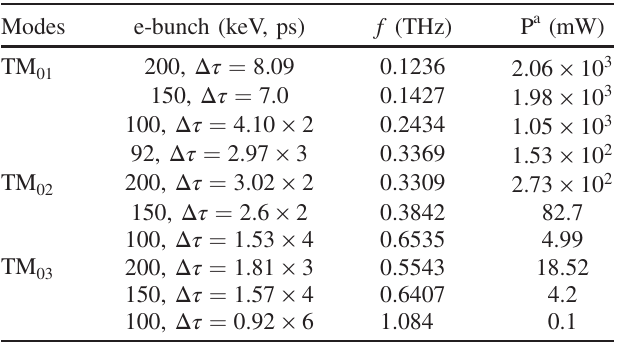
TABLE I. Radiation parameters for different bunch trains. Modes e-bunch (keV, ps) f (THz) TM